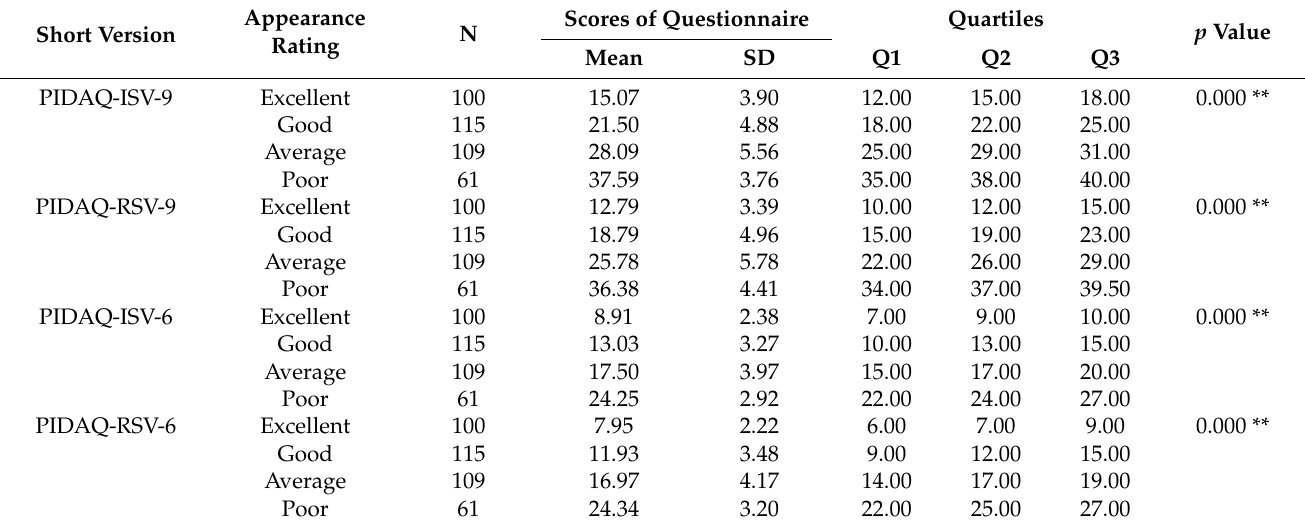
Table 10. The convergent validity: association between all PIDAQ(A) short versions with self- perceived dental appearance rank (n =